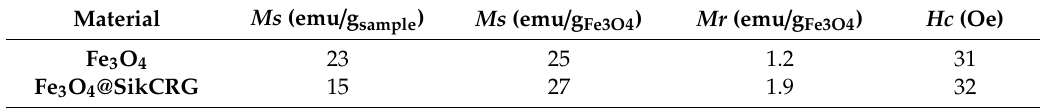
Table 2. Magnetic parameters for Fe 3 O 4 and Fe 3 O 4 @Si κ CRG particles, at 300 K.